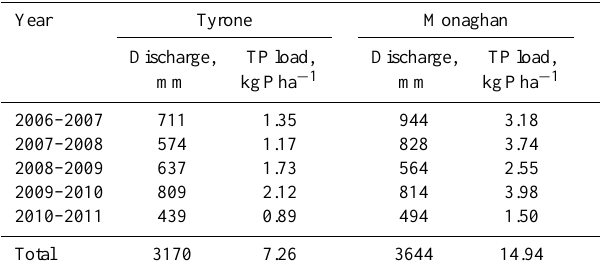
Table 4. Annual discharge and TP load from catchments 2006–